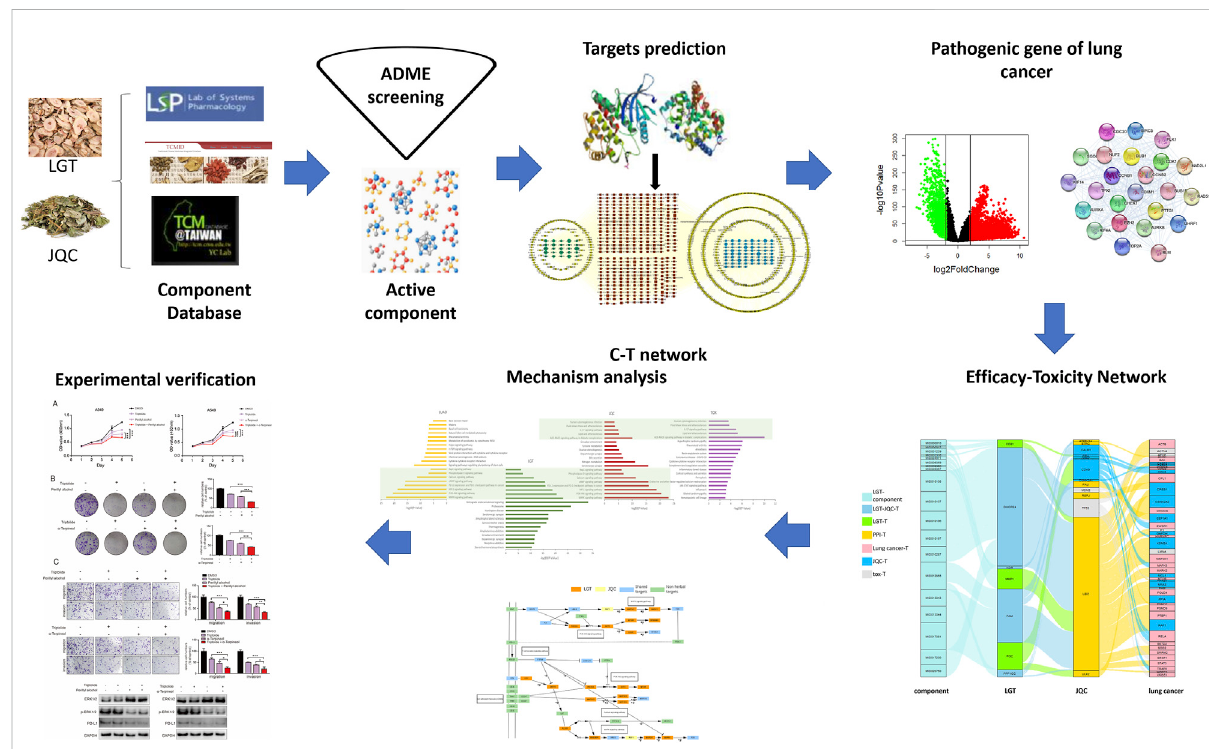
FIGURE 1 The fl owchartschemeofourproposedquantitativeintegrationmethodofdualef fi cacyandtoxicity.LGTstandsfor Tripterygiumwilfordii Hook. f., JQC stands for Lysimachia christinae